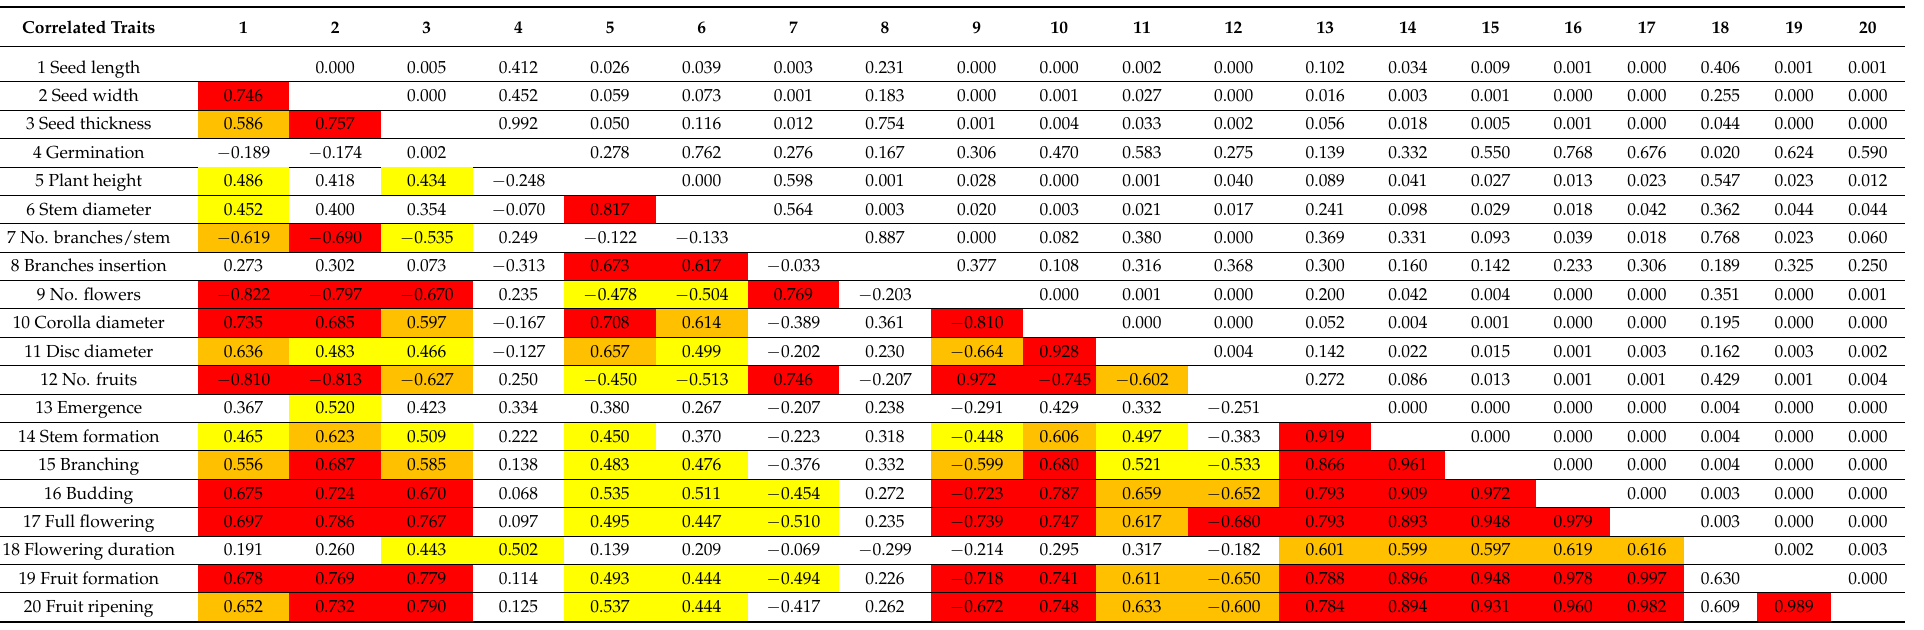
Table 5. Phenotypic correlations between the pairs of traits analysed (below the diagonal) and the p -value of the correlation (above the diagonal). Correlations were calculated from the mean values of each of the 21 cultivars